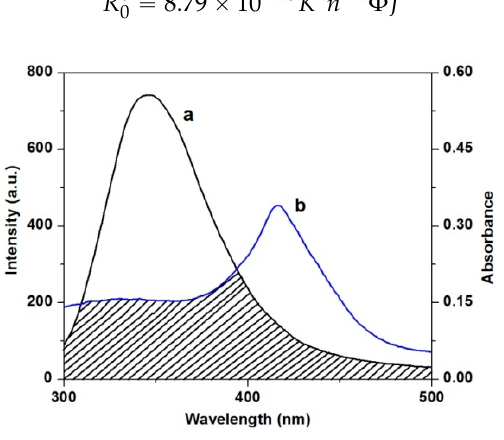
Figure 10. Spectra overlap of the fluorescence spectra of HSA ( a ) with the absorption spectra ( b ) of TCPC .